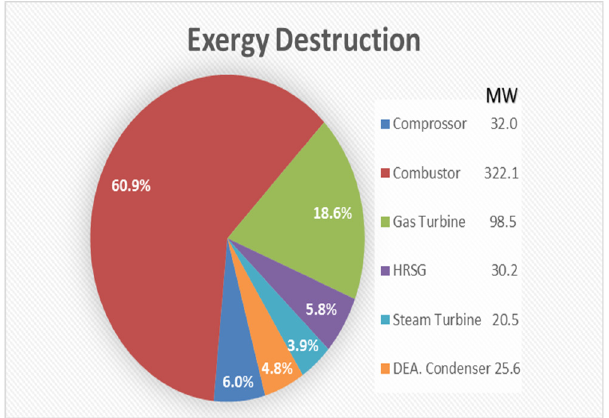
Figure 3. Exergy destruction rates for all components in Sabiya CCPP at ISO condition.